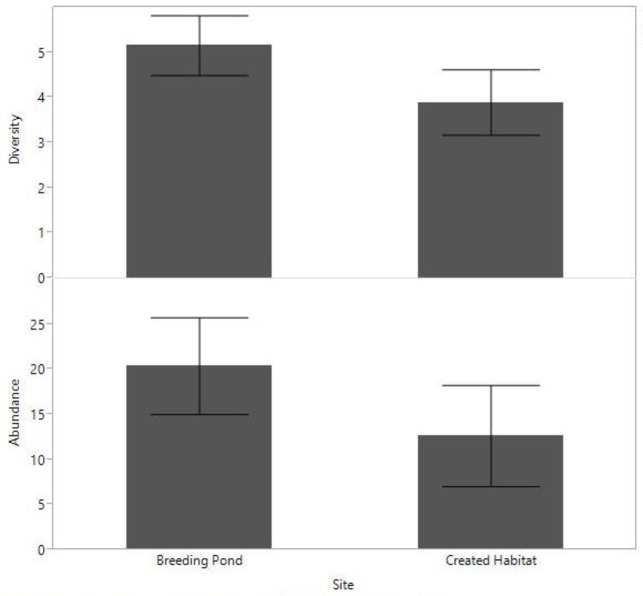
Mean abundance and diversity of terrestrial invertebrates captured in pit-fall traps at the created habitat and breeding pond.Error bars represent 95% confidence intervals